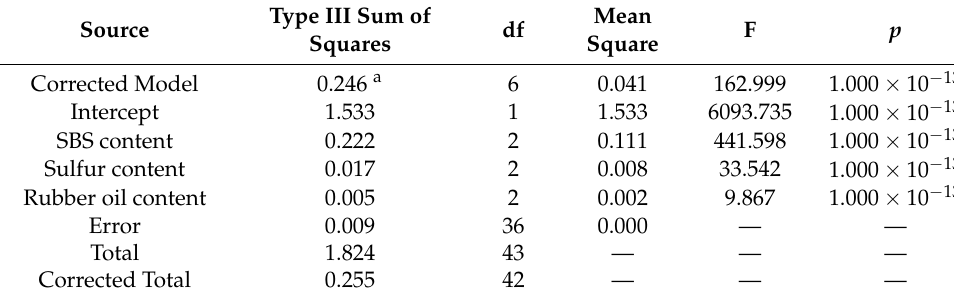
Table 6. Inter-subject effect test of three